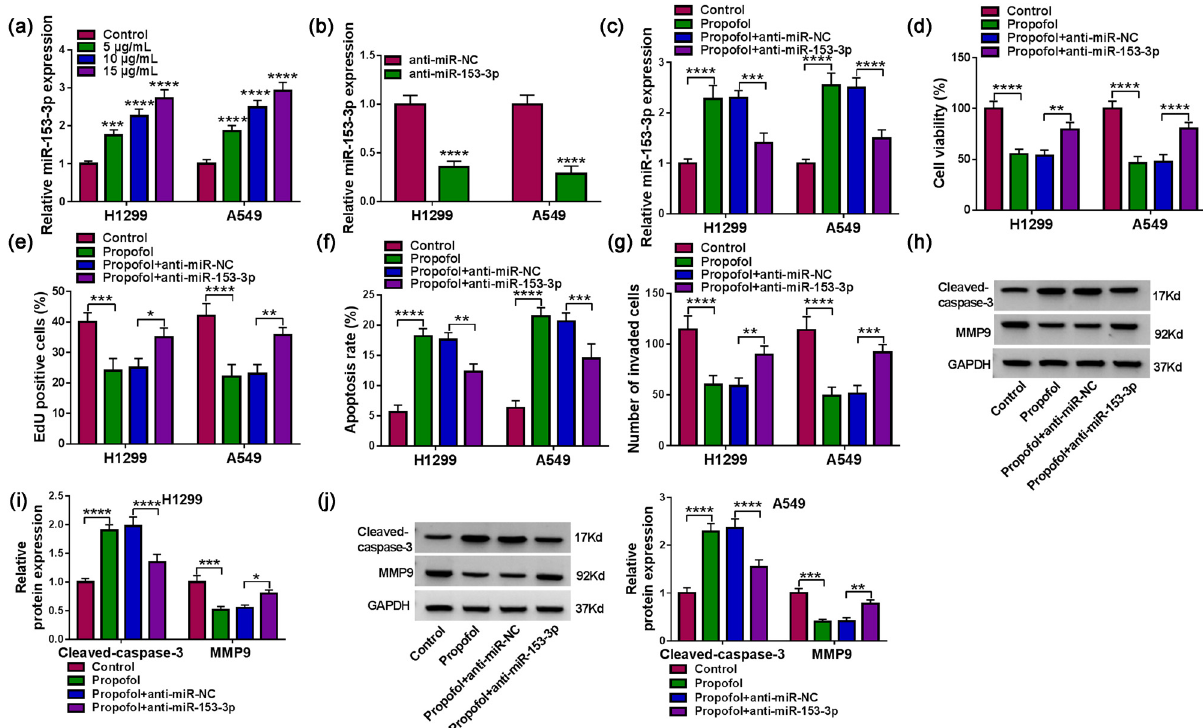
Figure A1: Overexpression of miR - 153 - 3p lowered NSCLC cell malignancy. ( a – d ) The viability, proliferation, apoptosis, and invasion of NSCLC cells transfected with miR - NC or miR - 153 - 3p were assessed by MTT, EdU, fl ow cytometry, and transwell assays ( n = 3 ) . *** P < 0.001 and **** P <